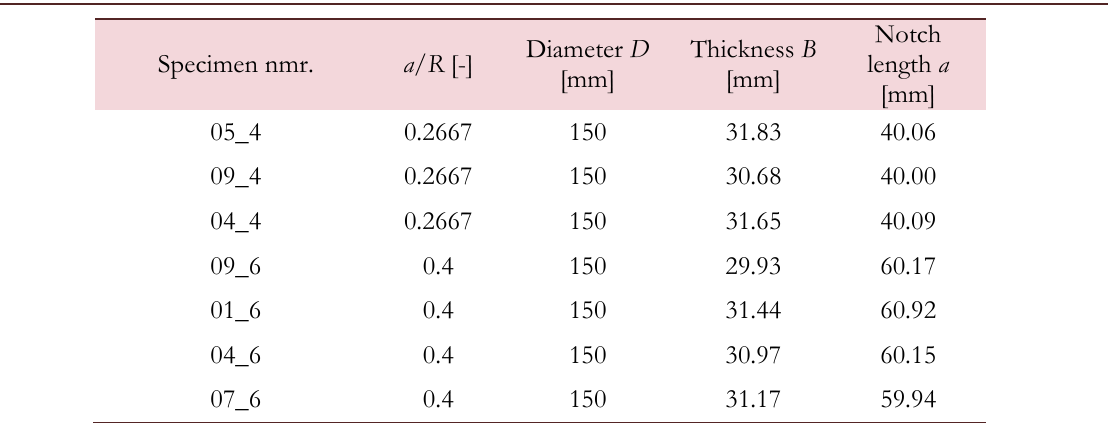
Table 2: Dimensions of Brazilian disc specimens with a center notch.